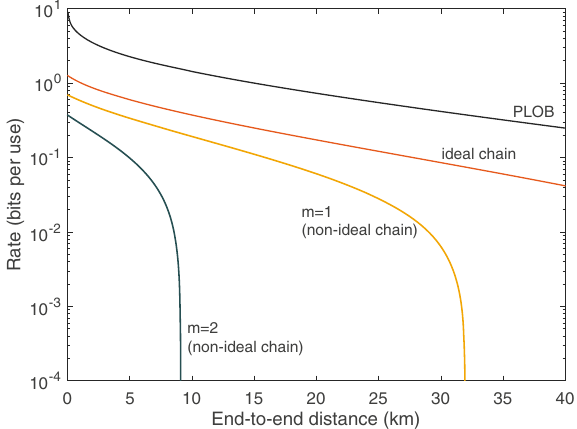
Fig. 4 Composable key rate per chain use. We consider a heterodyne-based CV-QKD protocol implemented over a quantum chain with depths m = 1 and m = 2. Here, we assume non-ideal Bell detection modules with η B = 0.95 and excess noise ϵ = 0.005 SNU for each single link. Other parameters are β = 0.98, N = 10 10 , m ϵ = 0 and β = 1) and the repeaterless capacity, i.e., PLOB bound 1